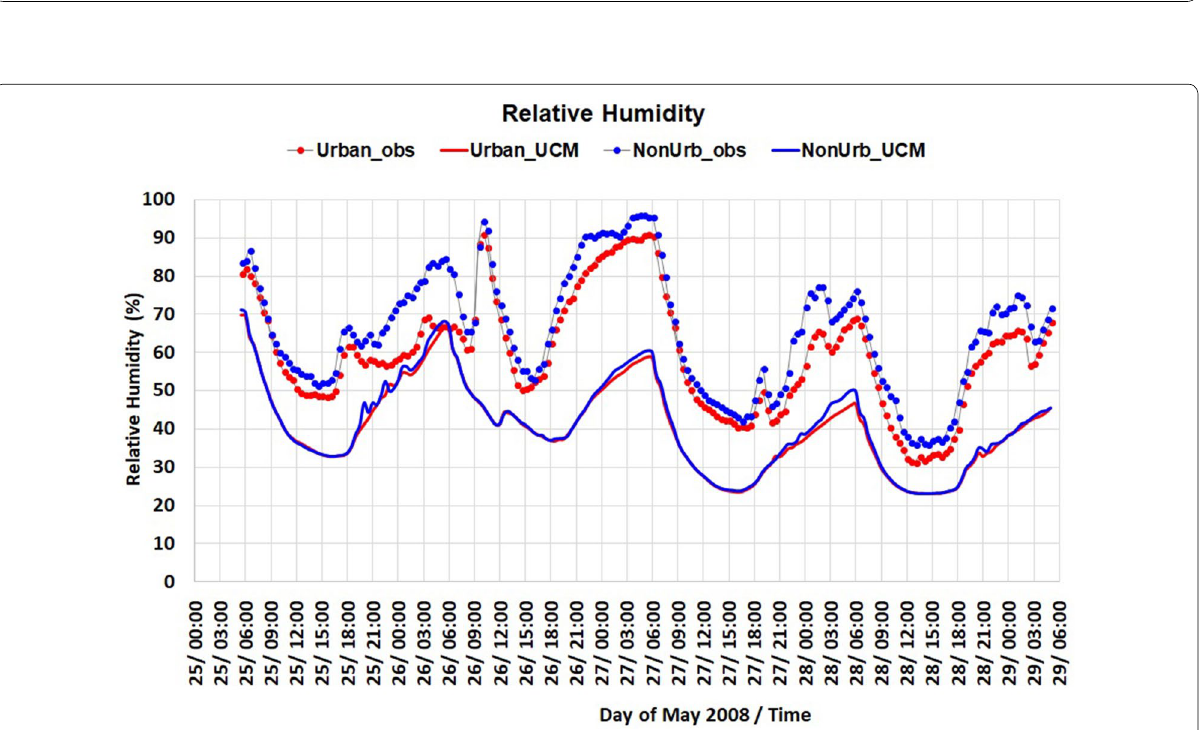
Fig. 6 Time series of relative humidity 25–28 May 2008 for WRF simulations with